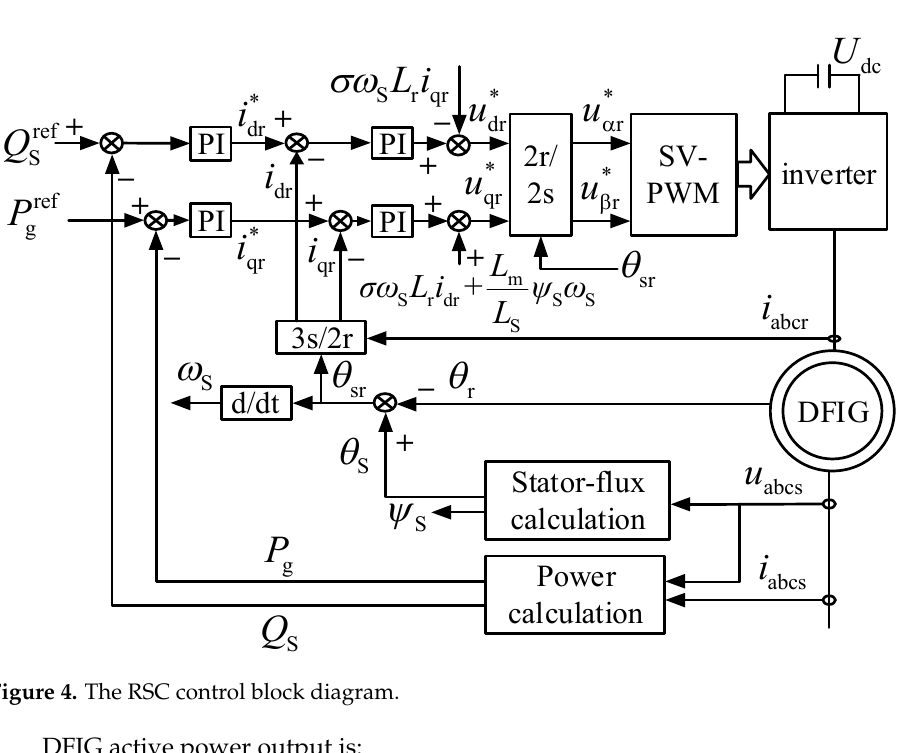
Figure 4. The RSC control block diagram.